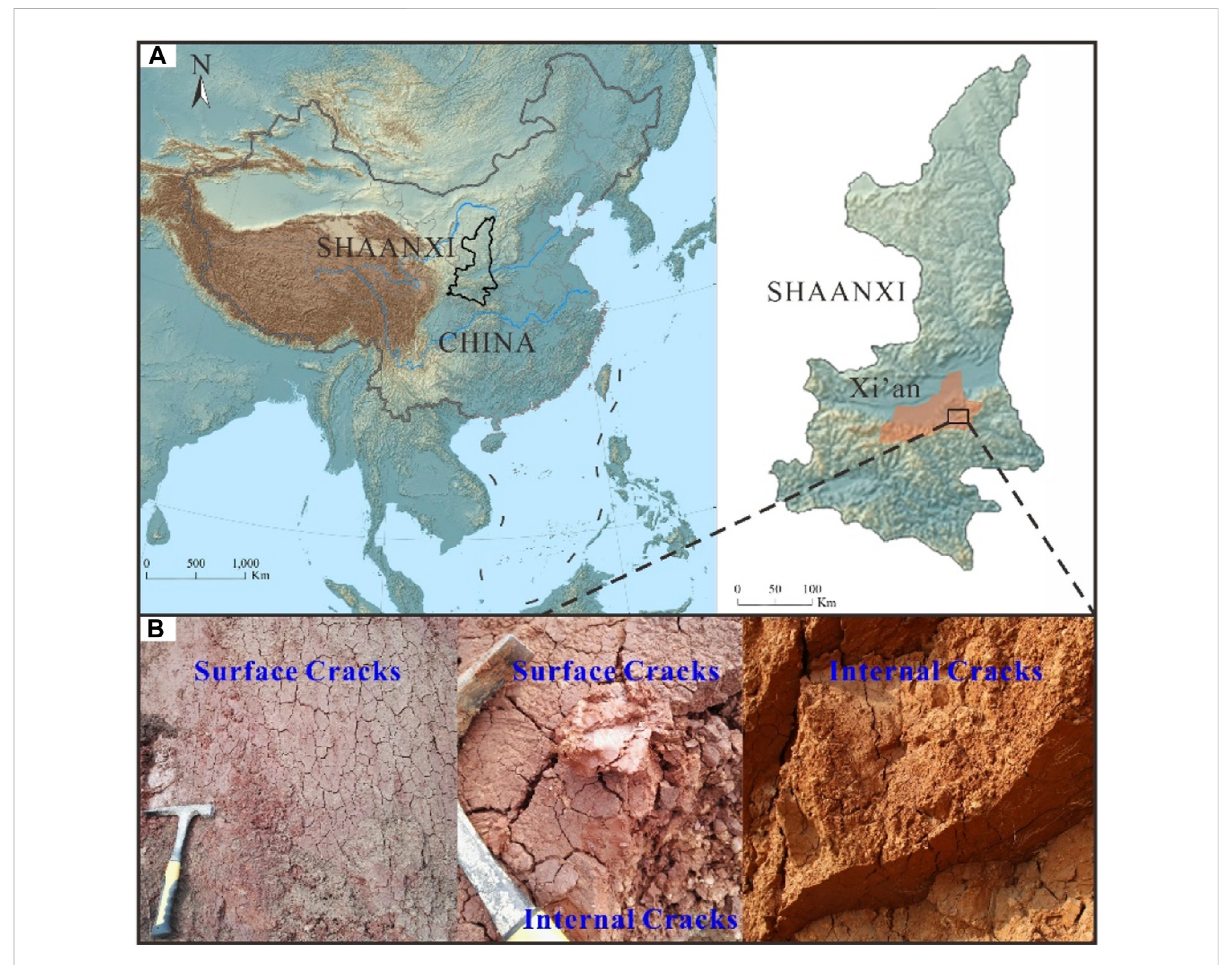
FIGURE 1 Sampling site of the Hipparion red clay. (A) Location of the study site, and (B) Desiccation cracks in Hipparion red